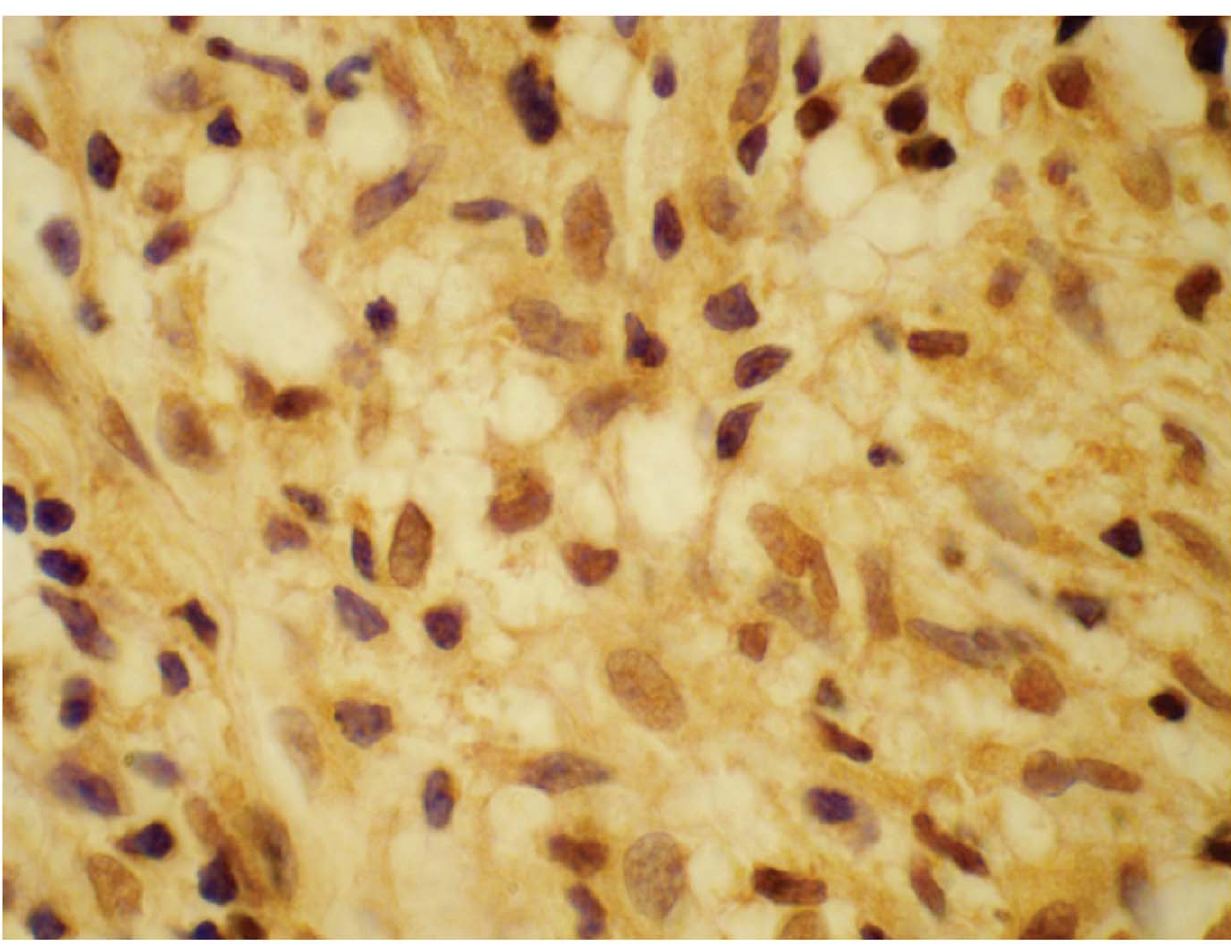
Figure 5. Skin stained for TGF- b . Skin showing TGF- b positive macrophages. IHC staining 6 100.